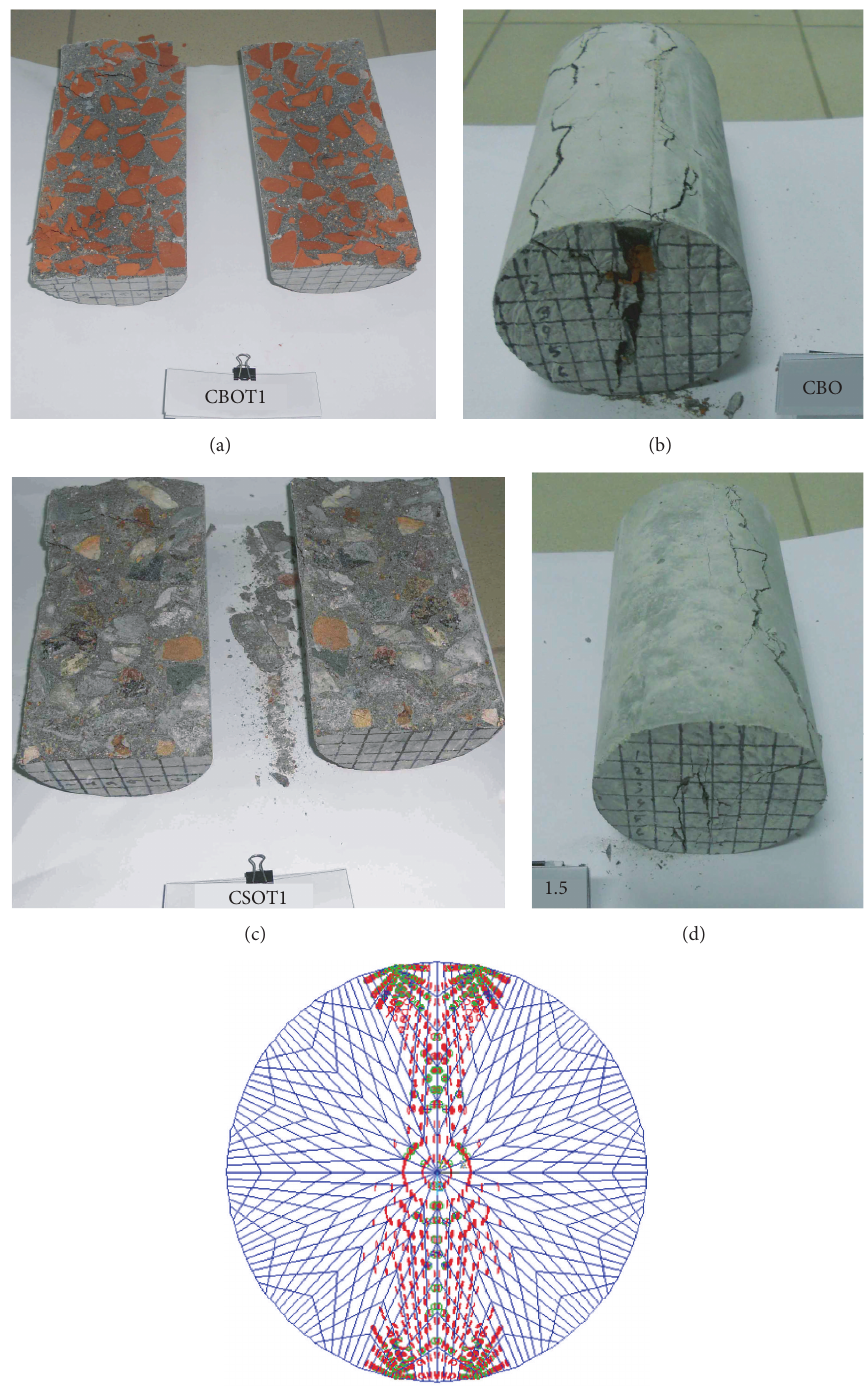
Figure 10: Failure patterns of splitting tensile specimens, (a) brick concrete, (b) brick SFRC, (c) stone concrete, (d) stone SFRC, and (e) failure pattern of FE